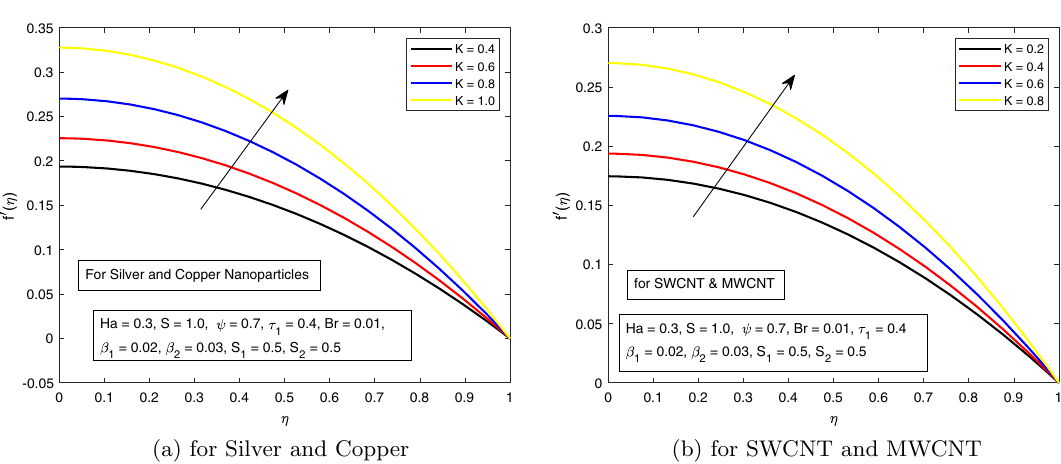
Figure 13. Influence of φ 2 on velocity profile f ′ ( r ) for the hybrid nanofluid combination of ( a ). Ag and Cu , ( b ) SWCNT and MWCNT